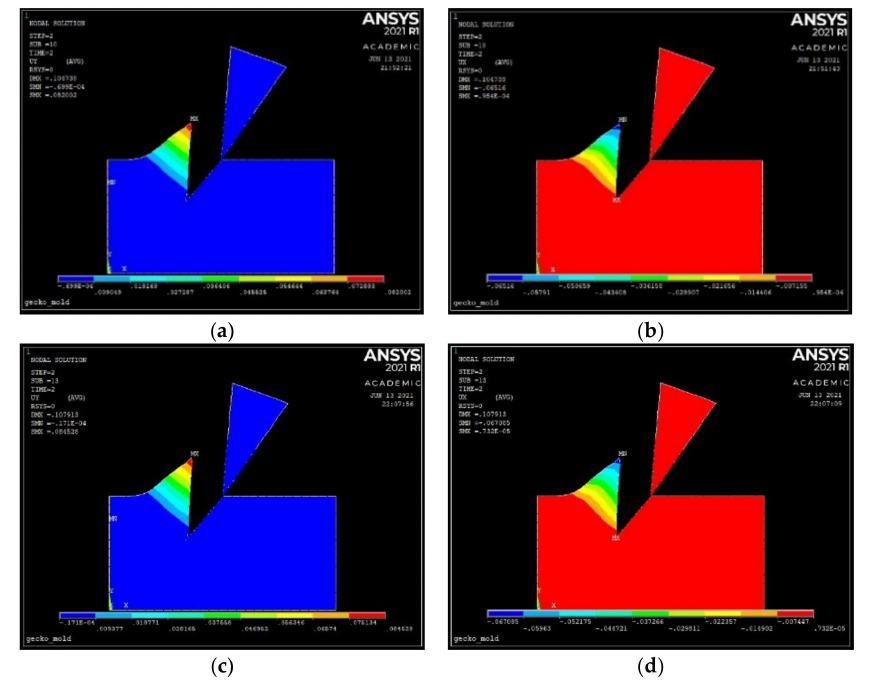
Figure 10. ( a ) Vertical and ( b ) horizontal displacement components for aluminum. ( c ) Vertical and ( d ) horizontal displace- ment components for